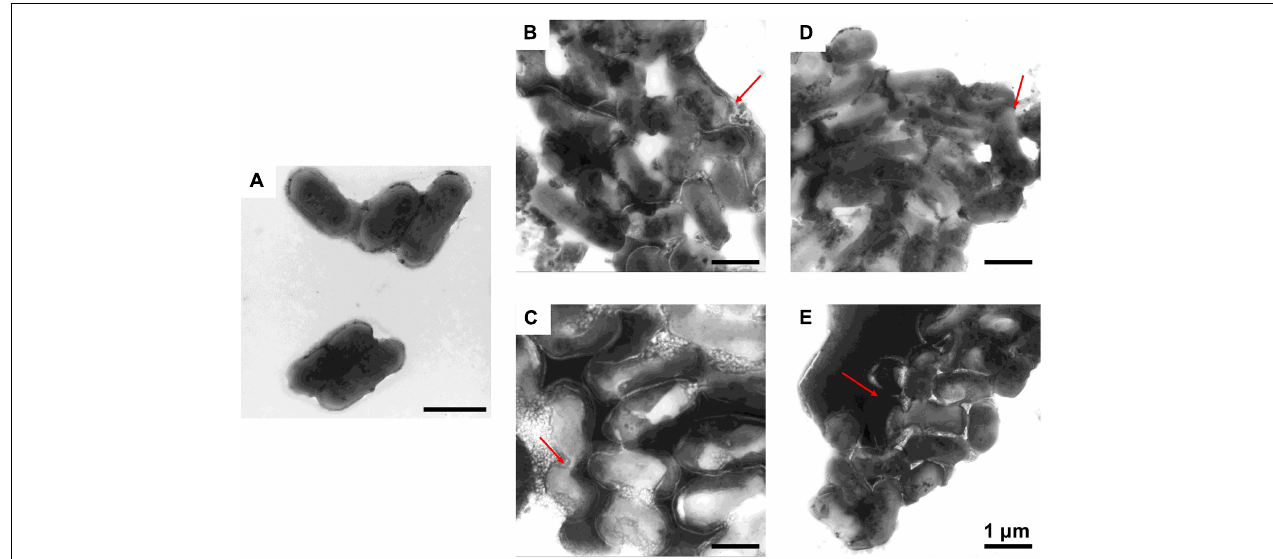
FIGURE 4 | Transmission electron microscopic observation of V. anguillarum . V. anguillarum incubated with PBS (A) or with 1–6, P-6, S-6, and L-6 (B–E) at 28 ◦ C for 30 min. The red arrow points to where the cell membrane has broken and the cell contents have flowed out.